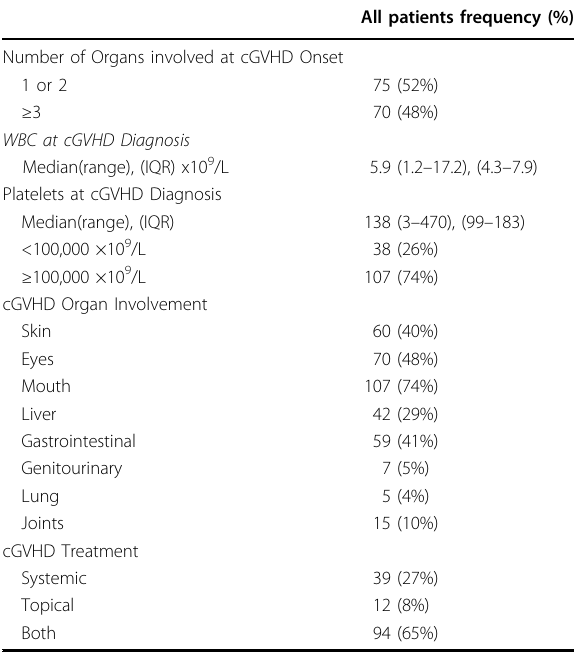
Table 2 Thromboembolism